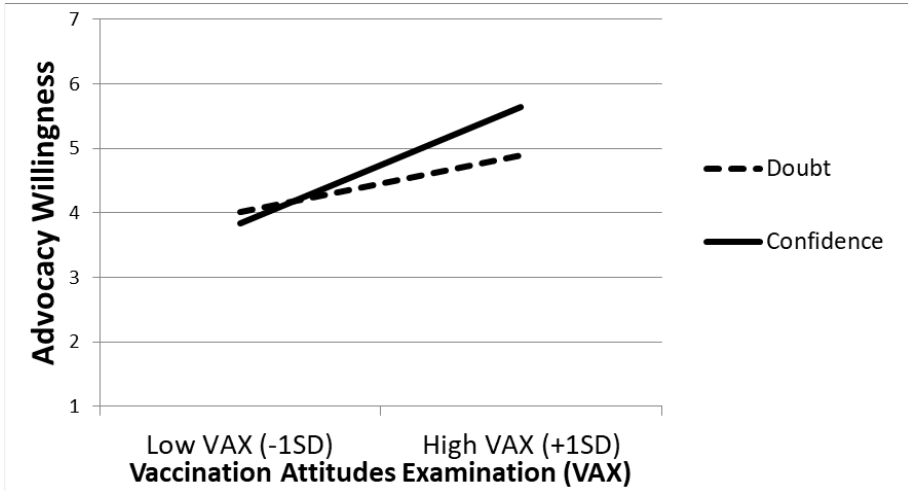
Figure 2. Study 2. Advocacy Willingness as a Function of VAX Responses and Manipulated Cer- tainty.